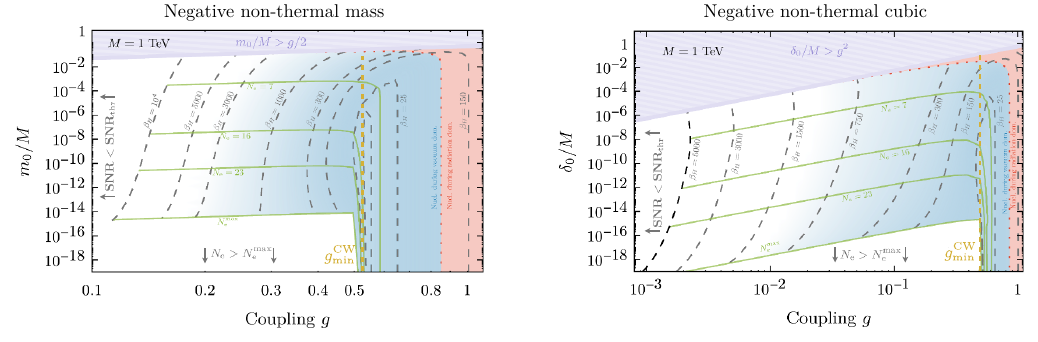
Figure 4 . Enlarging the supercooling window as a result of a temperature-independent deformation breaking conformal symmetry with a negative mass-squared (left) or a negative cubic (right) , for a fixed scale of M = 1 TeV . The gold dashed vertical line denotes the lower boundary of the super- cooling window for the CW model. The hatched purple regions indicate where the deformations are no longer a small perturbation of the original CW model. Dashed gray contours are growing values of β H whose scaling is fully capture by eq. (3.24). The light blue shading indicates the region where a GW signal is detectable. In the white region to the left β H has grown so that no detectable signal can be within the reach of any planned GW experiment. The light green curves indicate the number of e-folds during the inflationary period induced by the PT transition as defined in eq. (3.9). In the white region below the N max e the period of inflation is incompatible with CMB